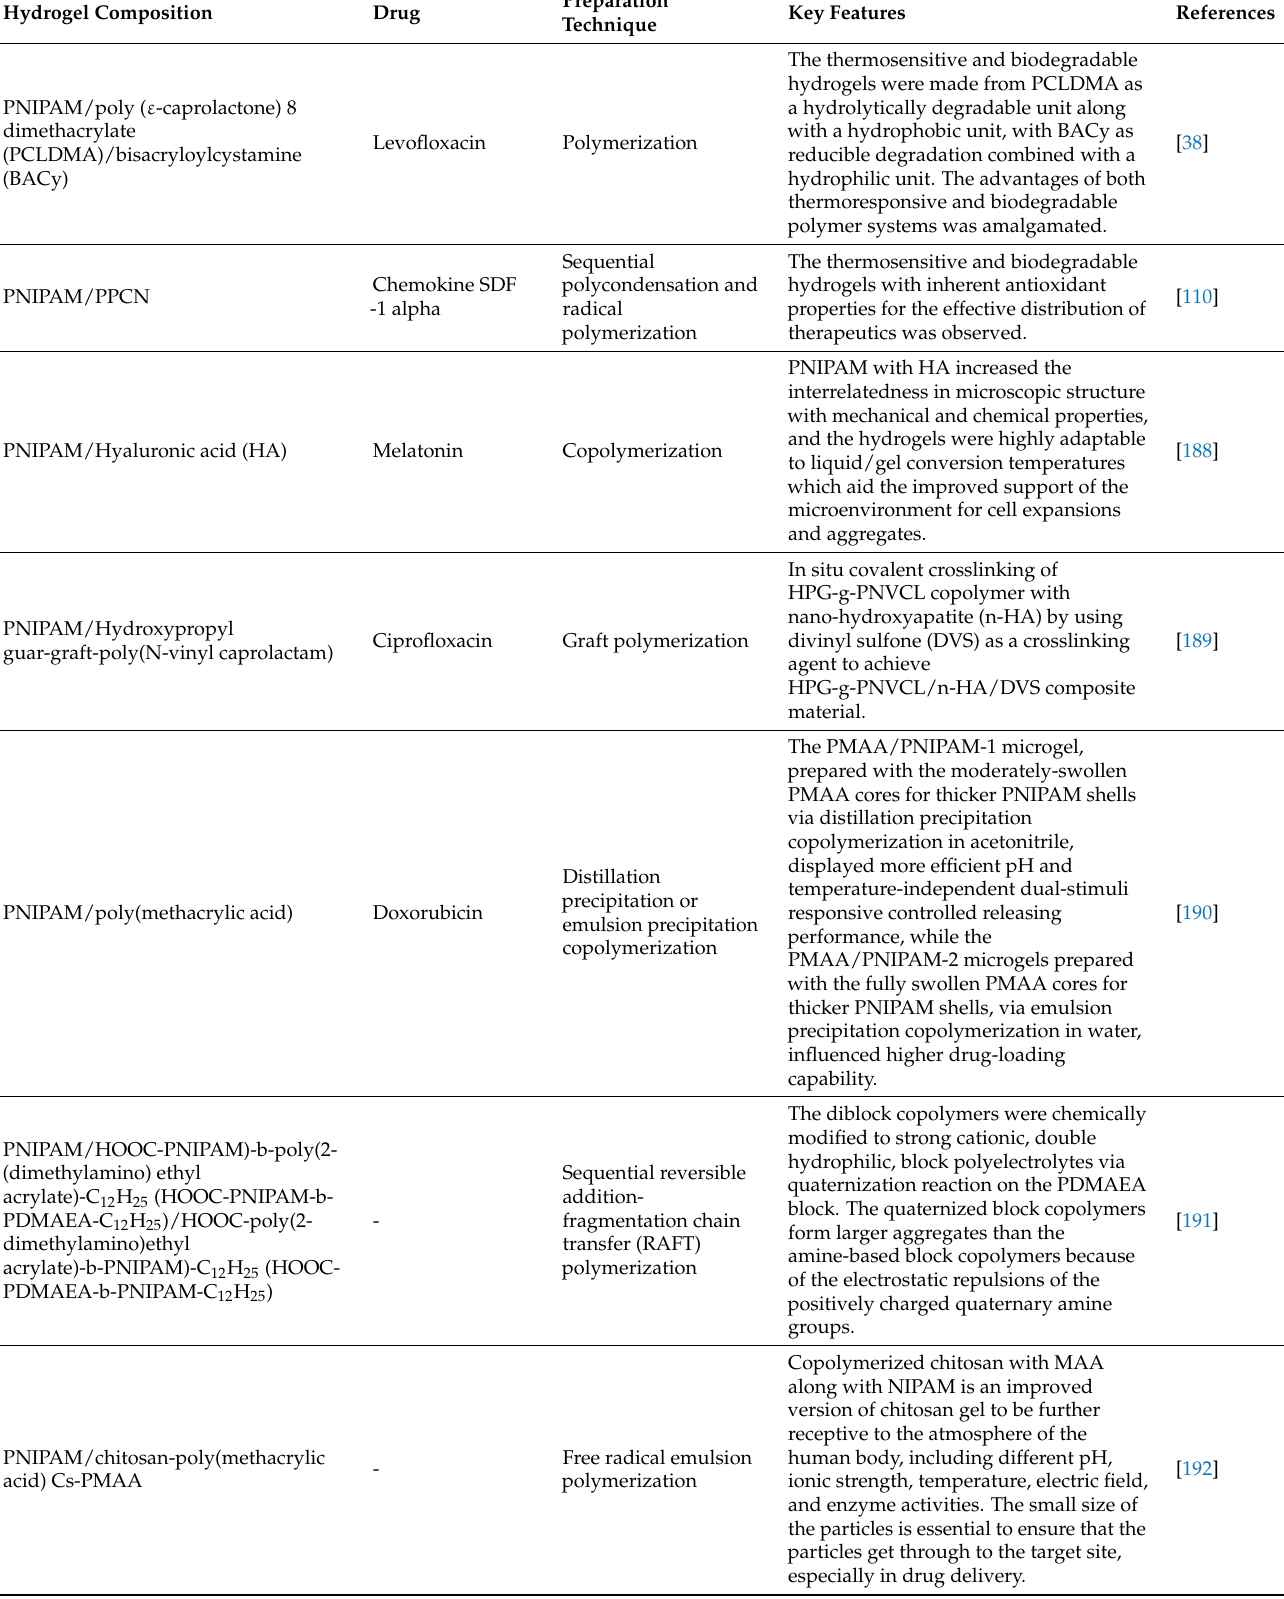
Table 1. Current studies on PNIPAM-based hydrogel in drug